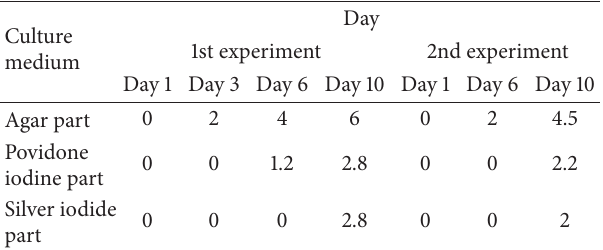
Table 2: Conductance silver iodide bacteriostasis experiment (unit